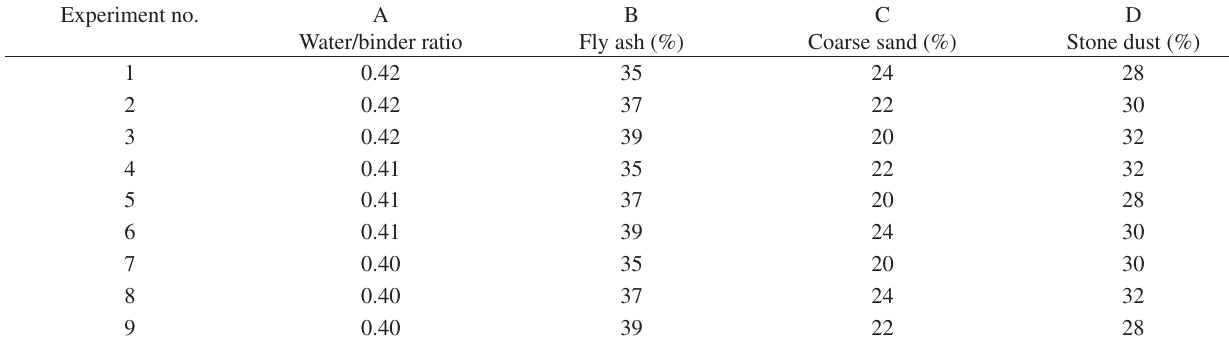
Table 3. Layout of experimental design (3 4 ). Experiment no.